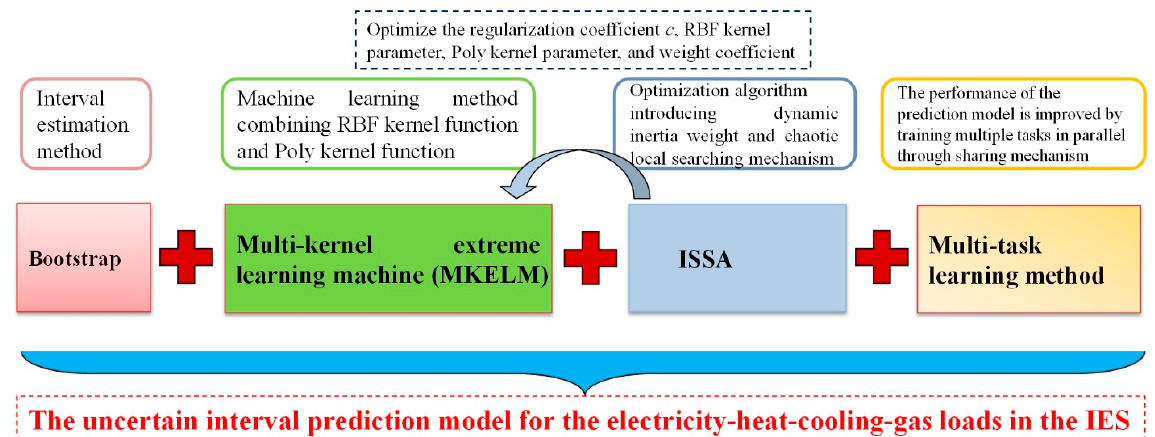
Figure 7. The role of each method contained in the uncertain interval forecasting model for the electricity-heat-cooling-gas loads on the demand side in the IES.